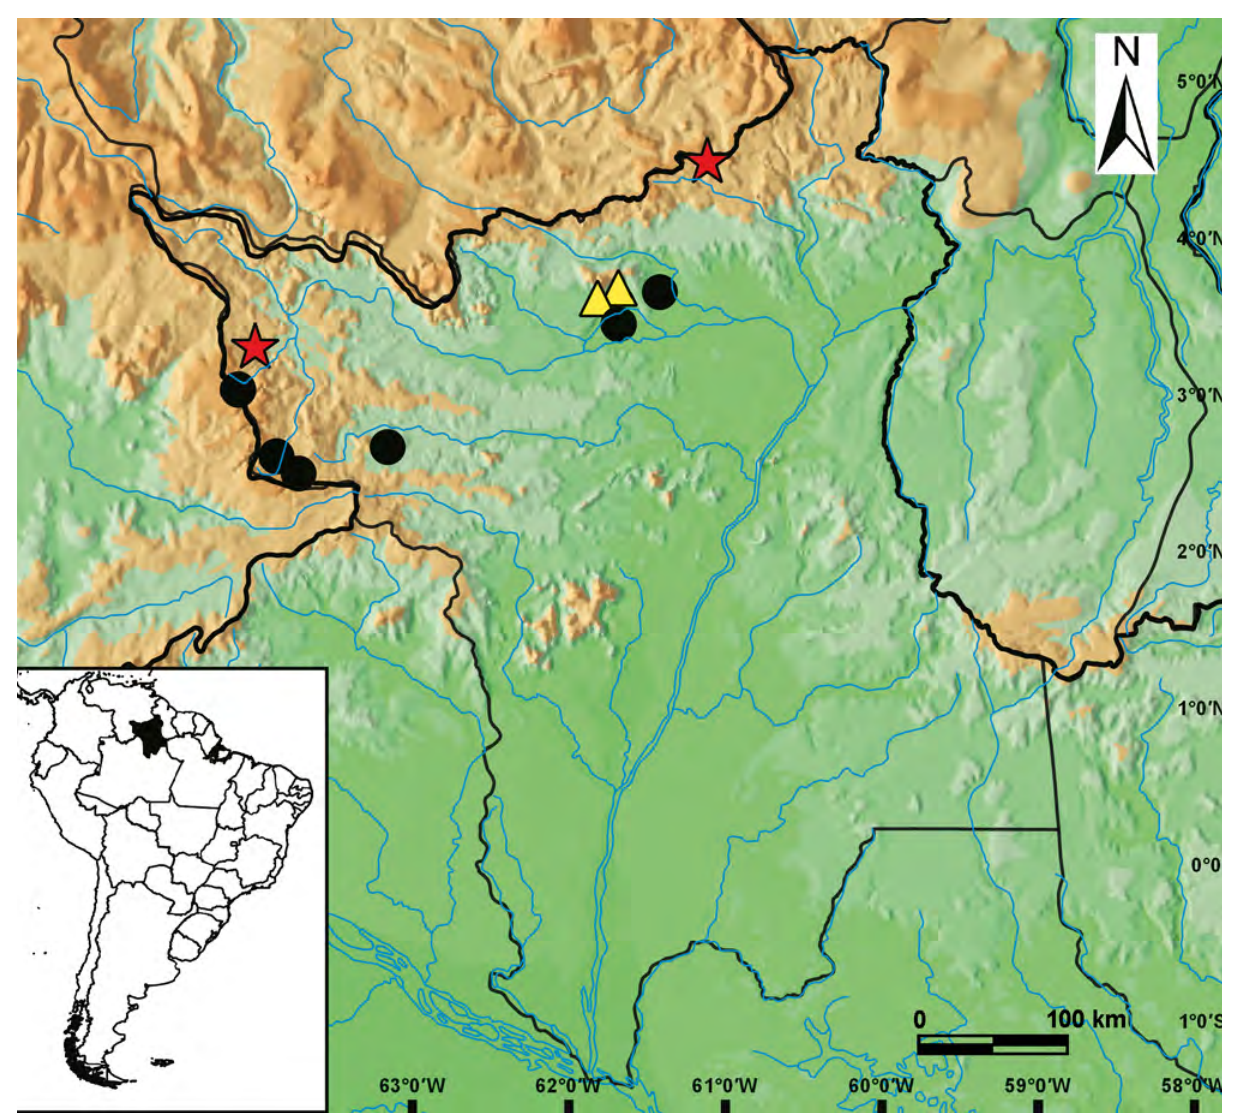
Figure 3. Distribution of the pseudothelphusid species, Fredius beccarii (Coifmann, 1939) (triangle), F. estevisi (Rodríguez, 1966) (star), and F. platyacanthus Rodriguez and Pereira, 1992 (circle), in the state of Roraima, Brazil. Fredius fittkaui (Bott, 1967) (Figs. 1D,